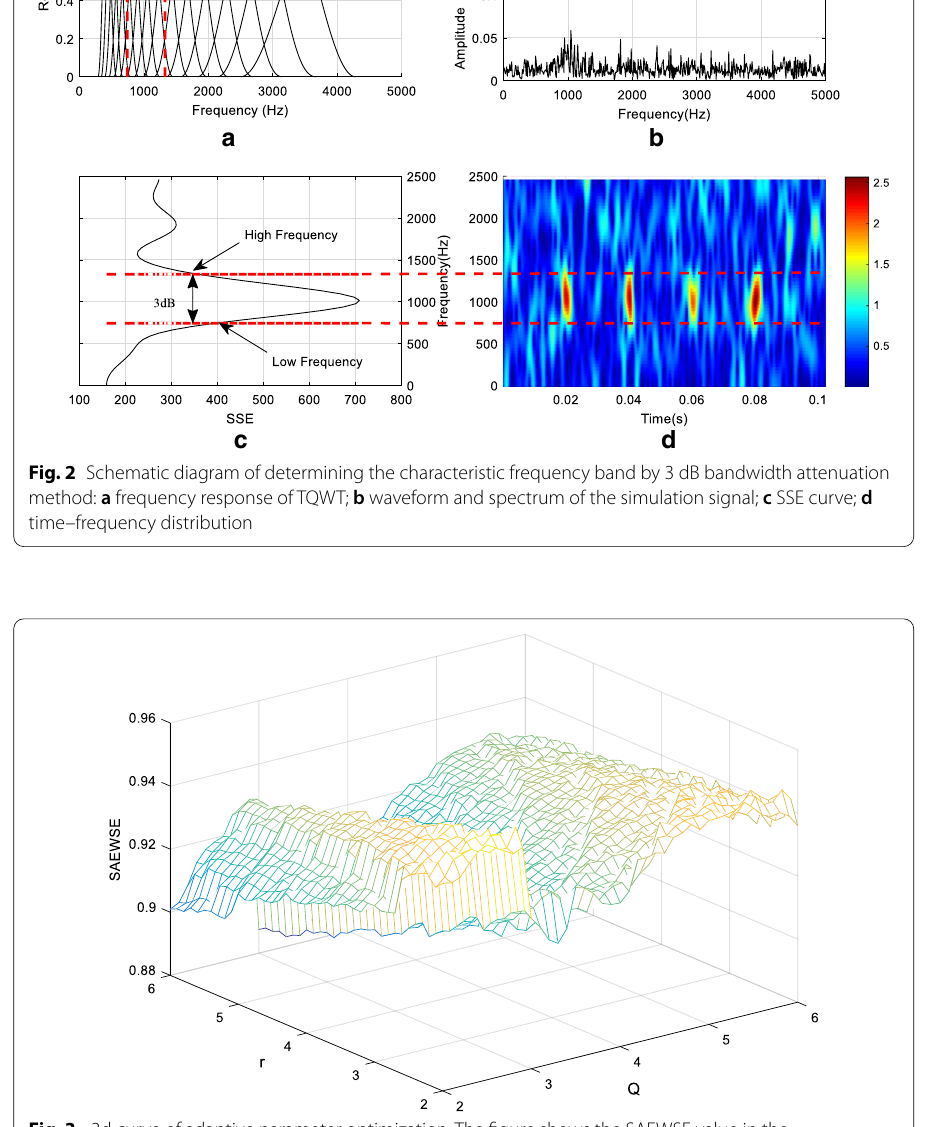
Fig. 3. 3d curve of adaptive parameter optimization. The figure shows the SAEWSE value in the two-dimensional grid search space of parameter (Q,r); the optimal parameter ( Q opt = 3.1, r opt = 3.5 ) is determined according to the minimum value of SAEWSE